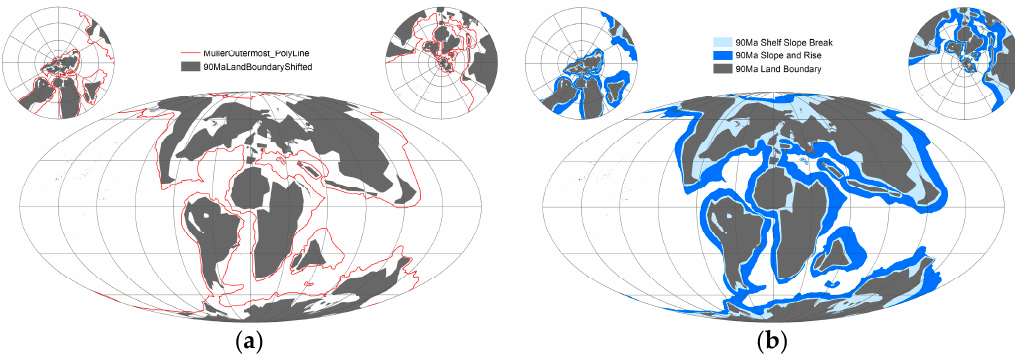
Figure 6. The extent of different 94 Ma ocean boundaries. ( a ) The maximum extent of the ocean crust in the ocean basins; ( b ) the extent of 94 Ma land, shelf, slope, and rise.